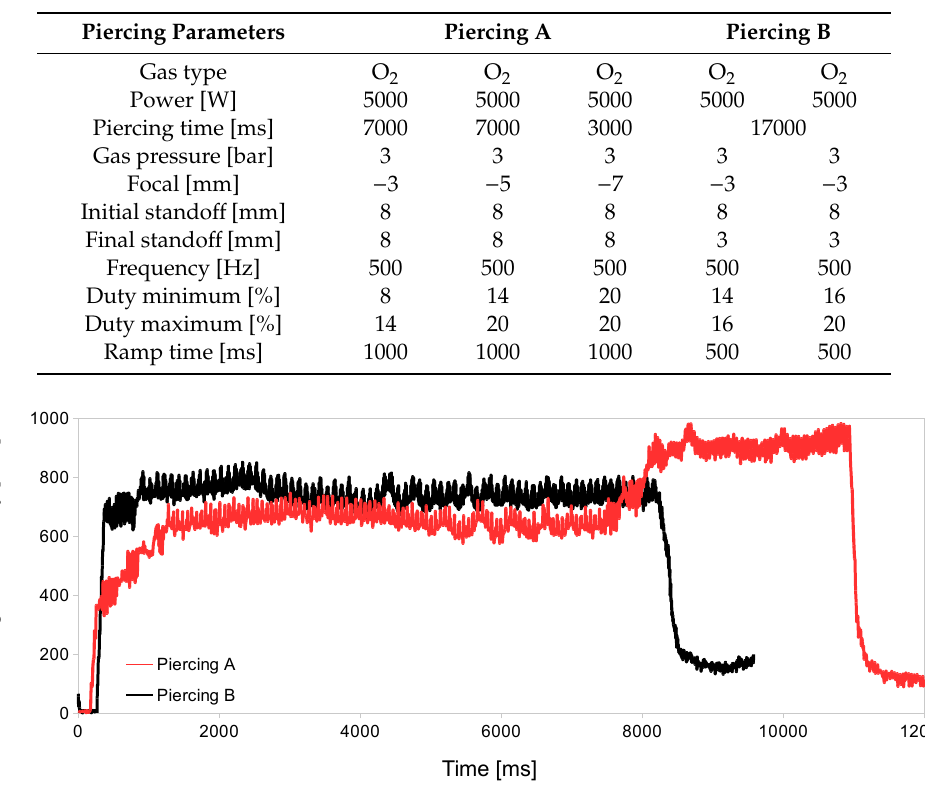
Figure 6. Piercing monitored signal for mild steel 20 mm thick, varying piercing strategy.